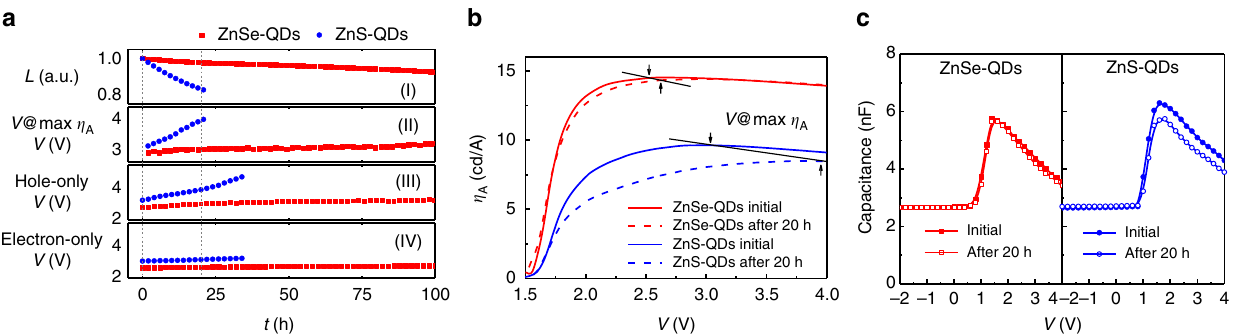
Fig. 3 Degradation mechanism. a , Normalized luminance ( L ) and operation voltage at maximum η A (V@ max η A ) vs. time for the ZnSe-QD and ZnS-QD devices operated at a constant current, and operation voltage vs. time of hole-only and electron-only ZnSe-QDs and ZnS-QDs based devices operated at a constant current. b Current ef fi ciency ( η A ) as a function of voltage for the ZnSe-QD and ZnS-QD devices measured before the lifetime test and after 20 h continuous operation. c Capacitance vs. voltage for the two devices measured before the lifetime test and after 20 h continuous